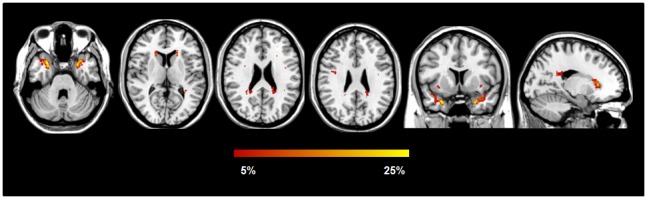
White matter hyperintensities spatial distribution in patients with myotonic dystrophy 1.The color scale (from 5% to 25%) represents the minimum to maximum probability of a lesion occurring in a particular spatial location. Results are overlaid on the coronal, sagittal and axial sections of the Montreal Neurological Institute standard brain in radiological convention (right is left).